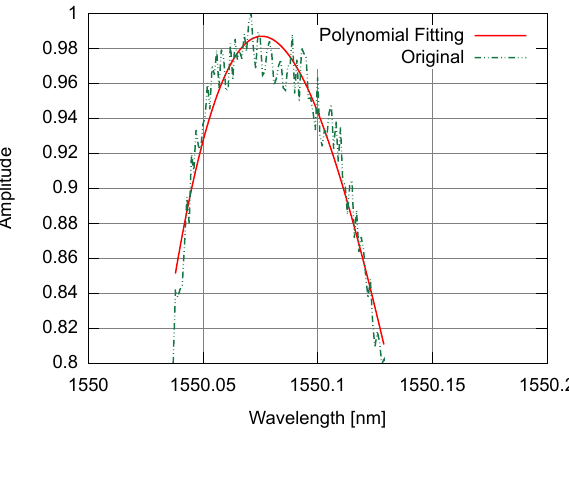
Figure 6. Example of polynomial fitting for a spectrum from a gaussian apodized